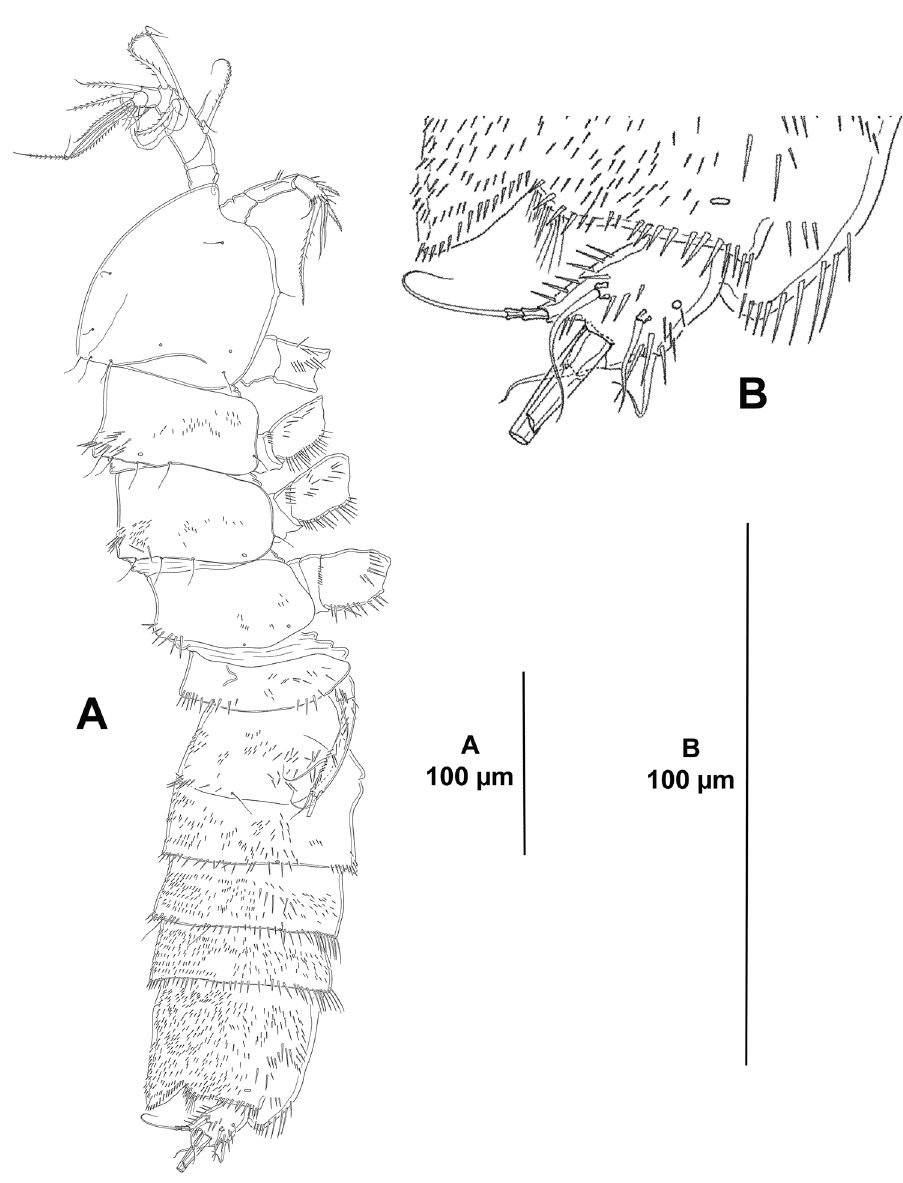
Figure 9. Odiliacletodes secundus sp. n., female holotype. A habitus, lateral B posterior part of anal somite and right caudal